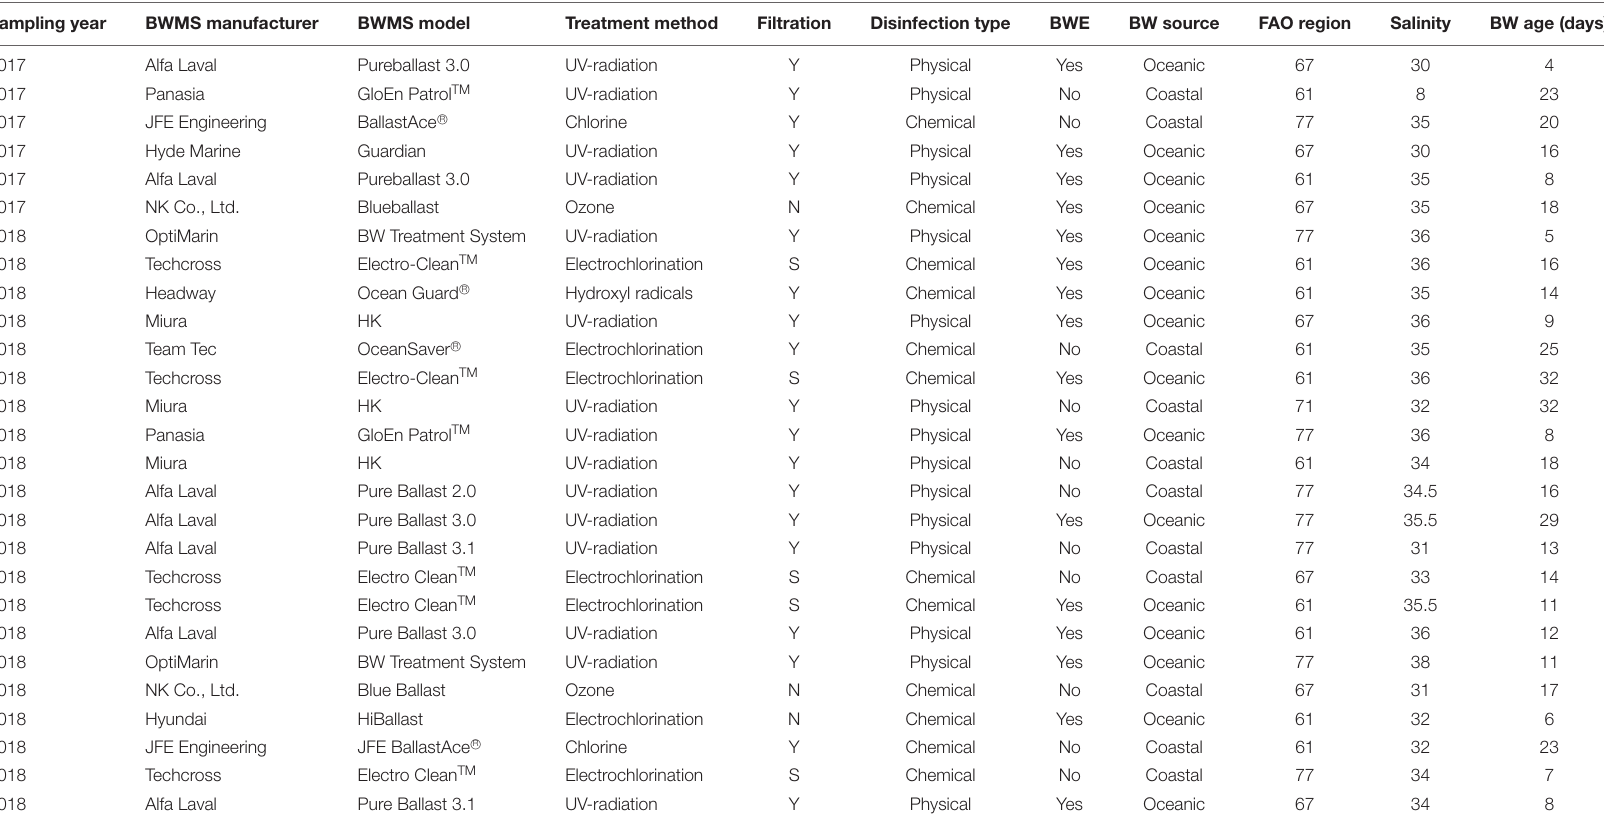
TABLE 1 | Characteristics of the different ballast water management systems (BWMS) and ballast water histories for ships sampled in 2017–2018. Sampling